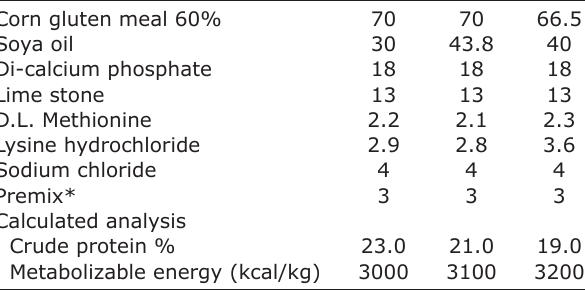
Table-1: Composition of the broilers 3-phase diets (g/kg as fed) and their calculated chemical composition. Corn gluten meal